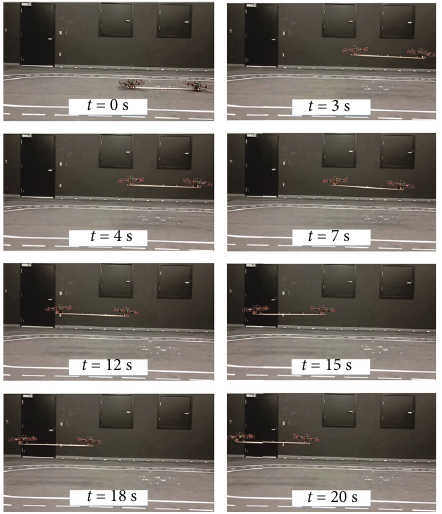
Figure 8: The snapshots of the test in Y